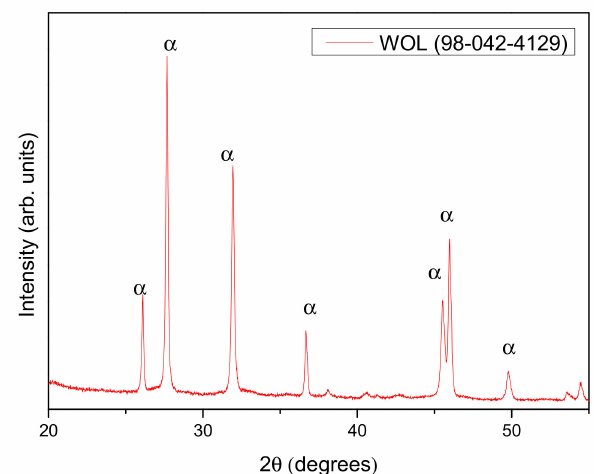
Figure 1. X-ray di ff raction pattern of α -wollastonite (WOL) synthesized.